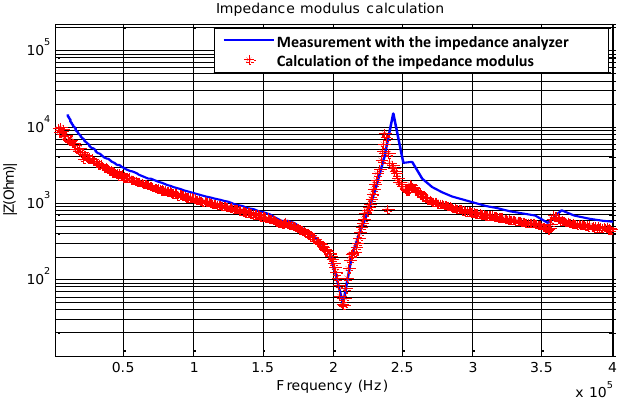
Figure 17. Comparison between the calculated impedance using signals of Figure 9(a,b) setup and the one measured using an Agilent 4294A impedance analyzer.